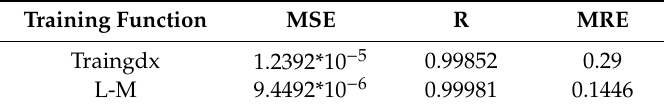
Table 4. Training results of di ff erent training functions.